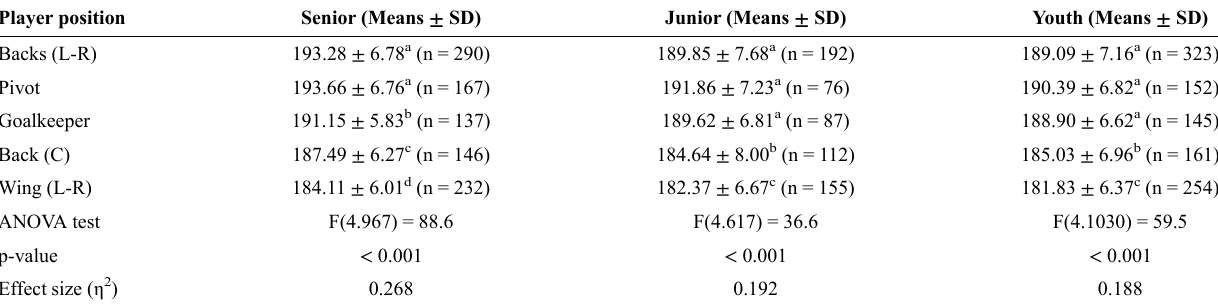
Table 3 - Descriptive (Mean ± SD) and comparative statistics of height (in cm) per player position in each age category. Between players positions ANOVA separately for each age categories. Player